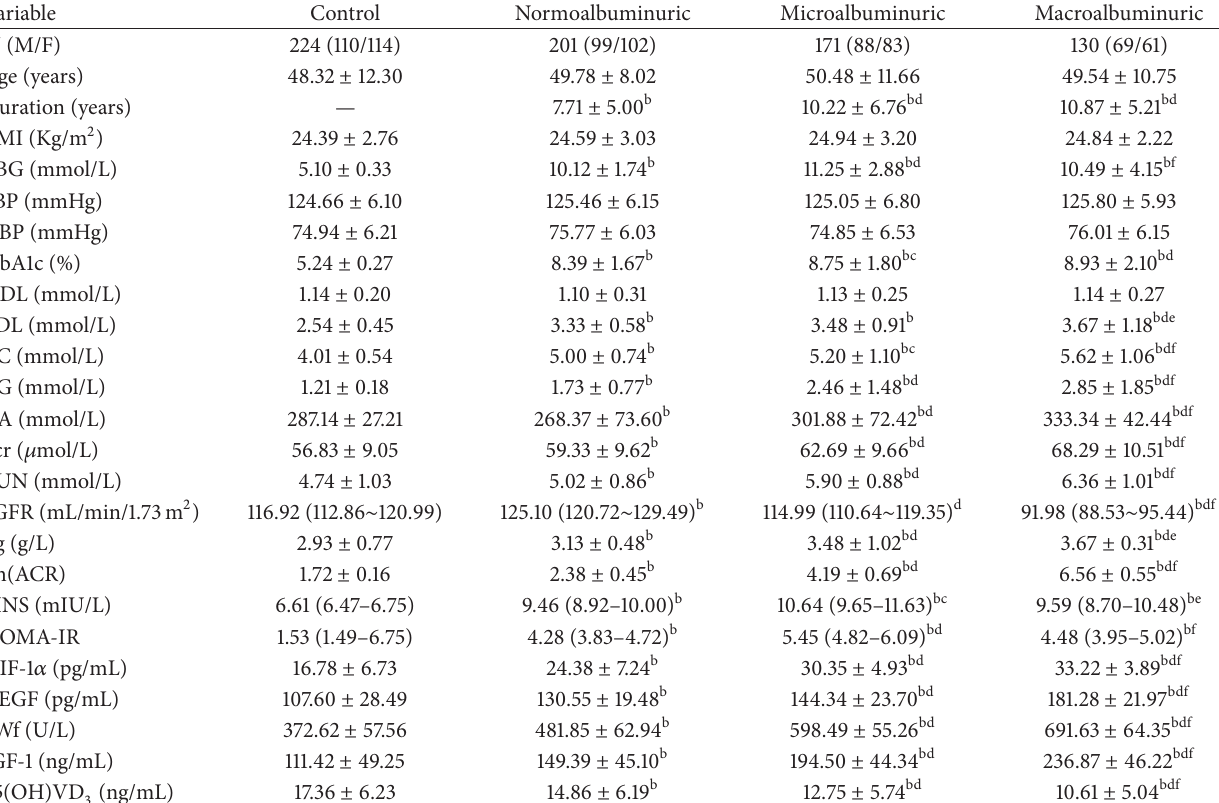
Table 1: Clinical characteristics and relative serum factors concentrations of type 2 diabetes patients and healthy